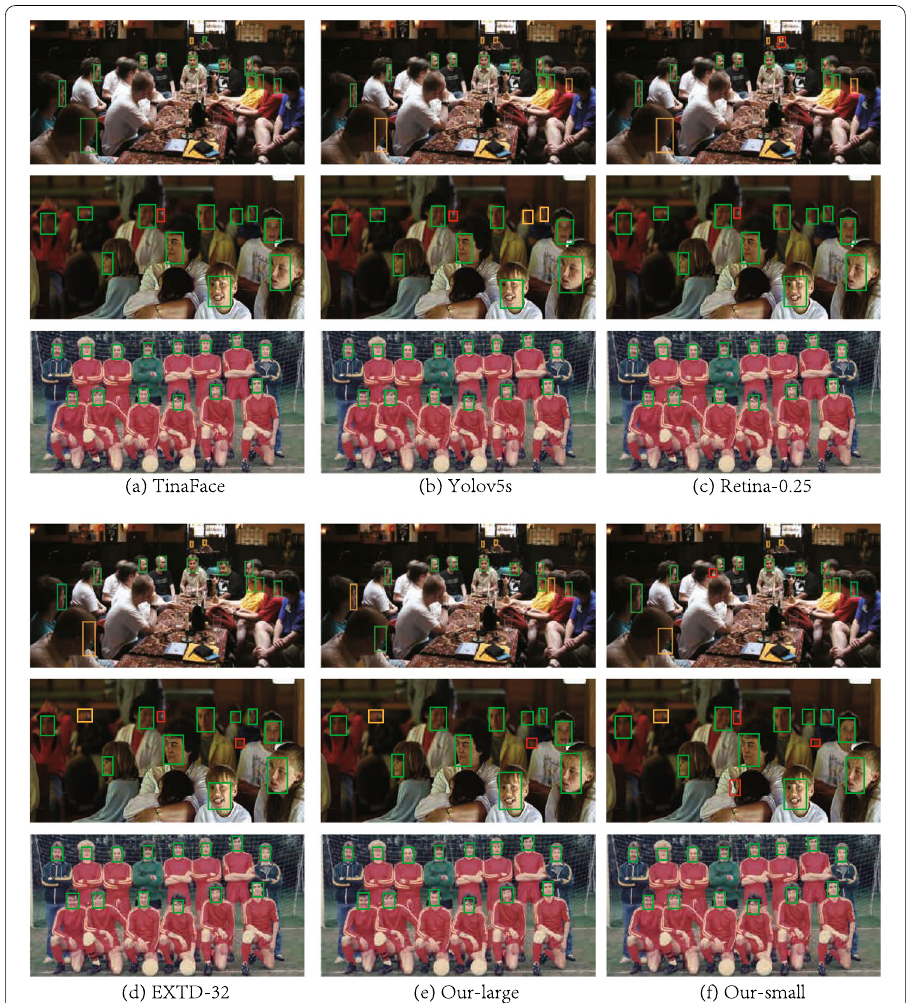
Fig. 9 Visualization of the detection results of six methods. The green, red, and orange boxes are the correct, incorrect, and missed detections,